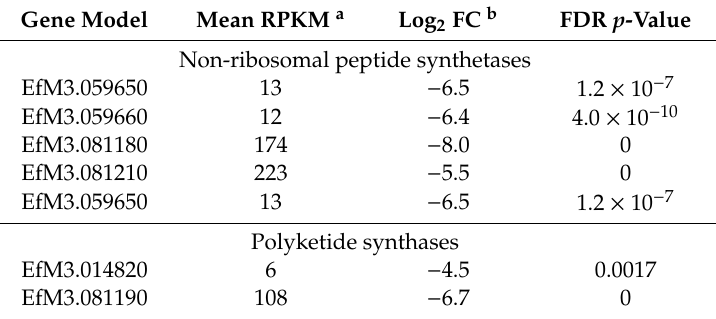
Table 9. Di ff erential gene expression of some Epichloë festucae non-ribosomal peptide synthetases and polyketide synthases between asymptomatic inflorescence tissue and choke stroma tissue at false discovery rate (FDR)-adjusted p <